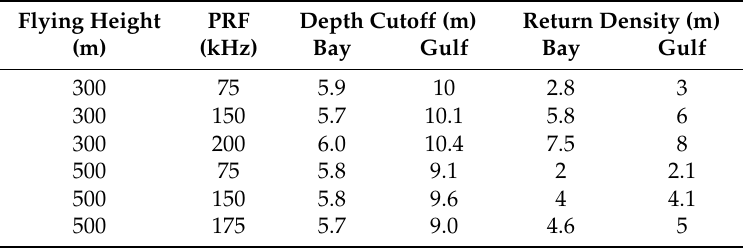
Table 5. Results from the water penetration tests under almost ideal bathymetric conditions near Destin, FL,